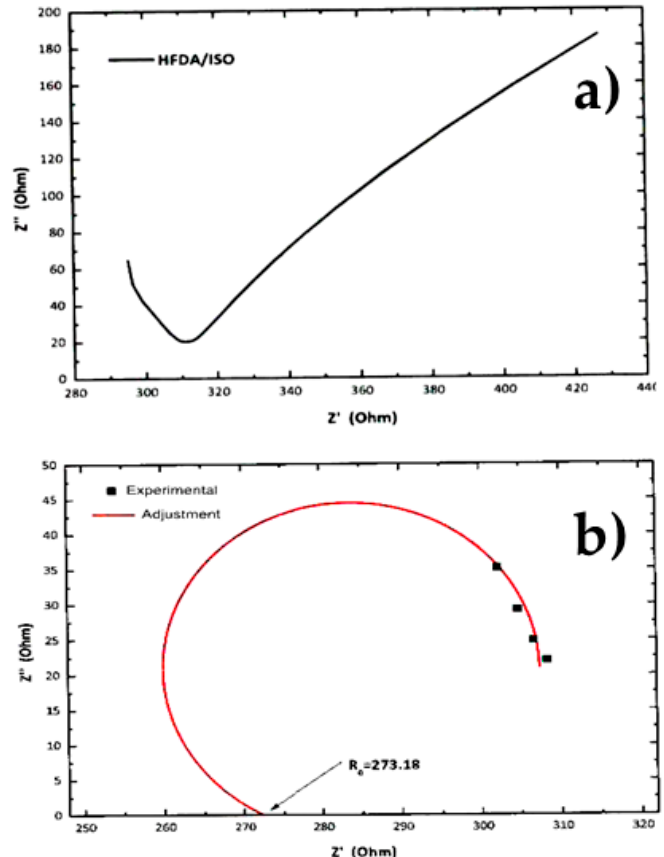
Figure 4. Characteristic EIS result and non-linear adjustment of ( a ) EIS curve for non-sulfonated HFDA / ISO, ( b ) adjustment for HFDA / DABS / ISO-90 / 10.